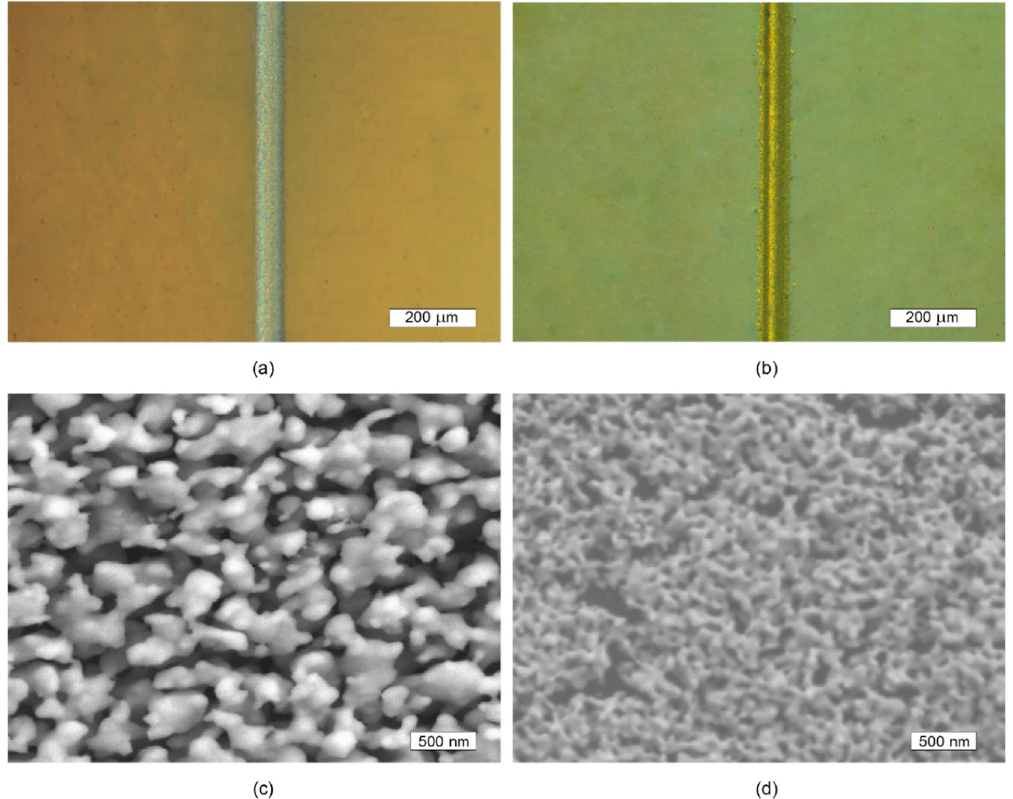
Figure 6. Characteristic images for silver lines sintered by laser radiation on polyamide substrates: ( a , b ) The general view obtained by optical microscope; ( c , d ) SEM images of line surface. Sintering was done by pulsed laser radiation with wavelengths ( a , c ) 527 and ( b , d ) 1054 nm in optimal regimes.